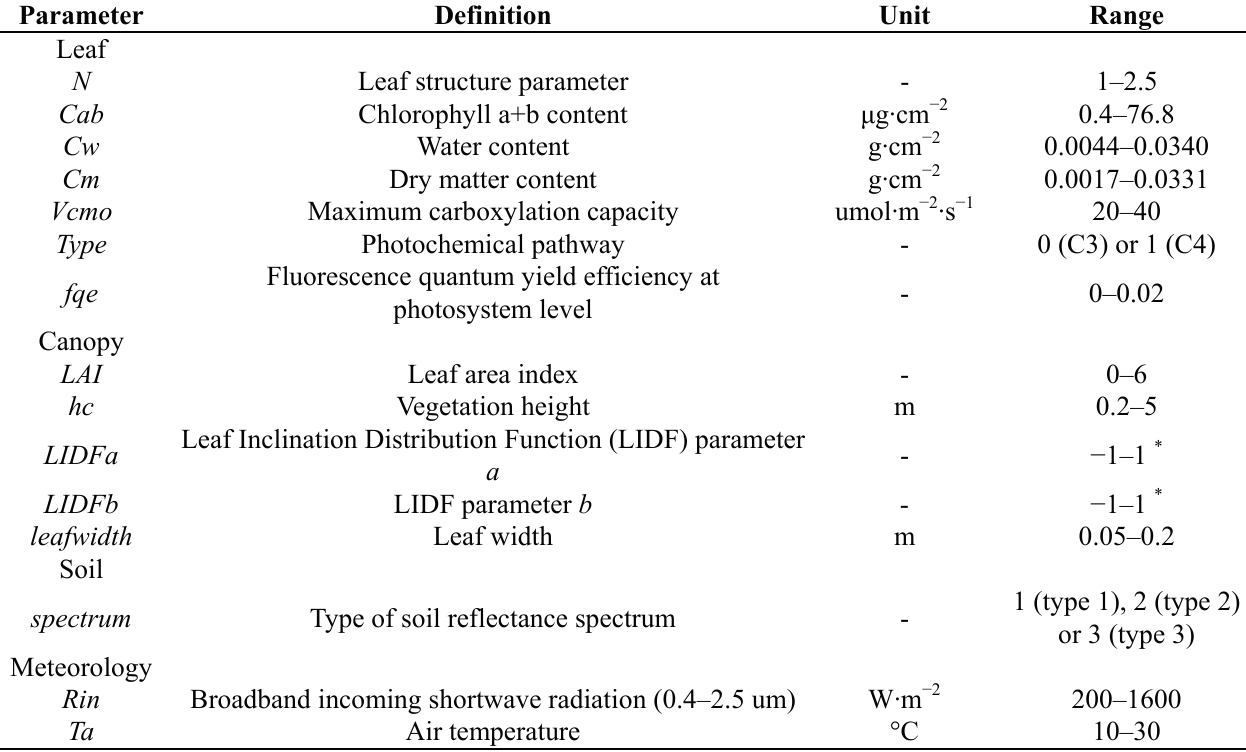
Table 1. The definitions and units of 15 input parameters of the model SCOPE (Soil Canopy Observation, Photochemistry and Energy fluxes). Variation ranges were assigned to these parameters, from which combinations were randomly selected to generate the simulated